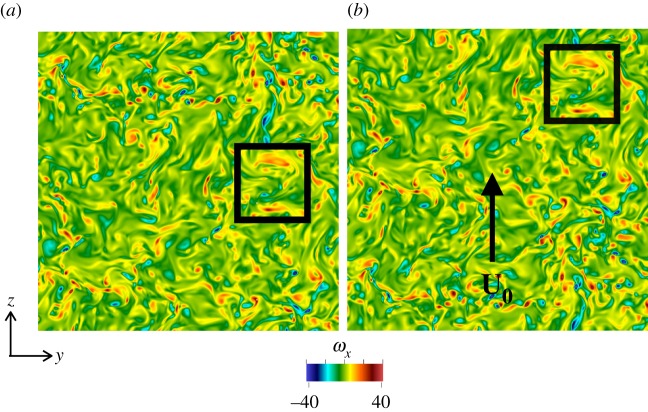
For hydrodynamic turbulence simulation with Re≈1100, and U0=0 and U0=10z^: The density plots of the vorticity component ωx of a vertical cross section for (a) U0=0 and (b) U0=10z^. The flow in (b) is shifted upwards by U0τ compared to (a).